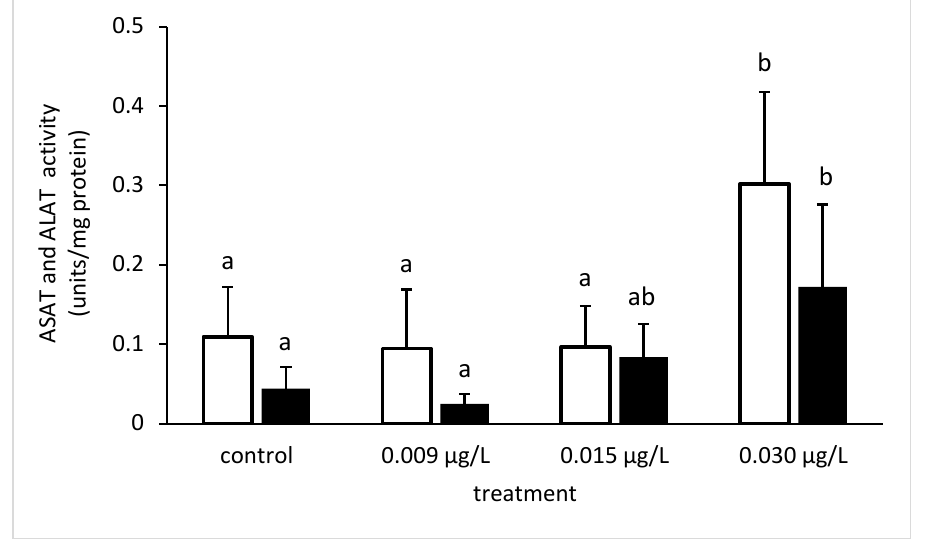
Figure 4. Aspartate aminotransferase (ASAT) (white bars) and alanine aminotransferase (ALAT) activity (black bars) in common carp liver under different CPF exposures. Bars represent means ± SD of the control and experimental groups. Different letters indicate significant differences among treatments ( p < 0.05).